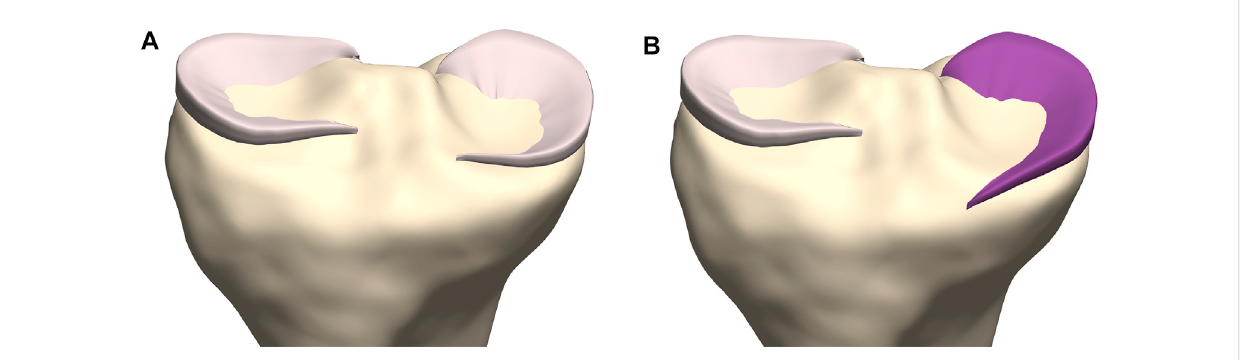
FIGURE 14 Coronal view on the tibial plateau (yellow). (A) Prediction of the medial meniscus according to the developed work fl ow demonstrates the type I insertion as described by De Coninck and colleagues. (B) By changing the anterior root insertion reference, a medial meniscus with a type III insertion is modeled (Mootanah et al.,